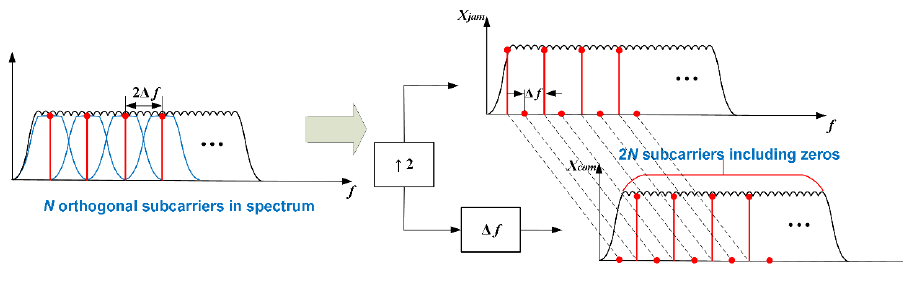
Figure 4. Symbol design of joint signal.